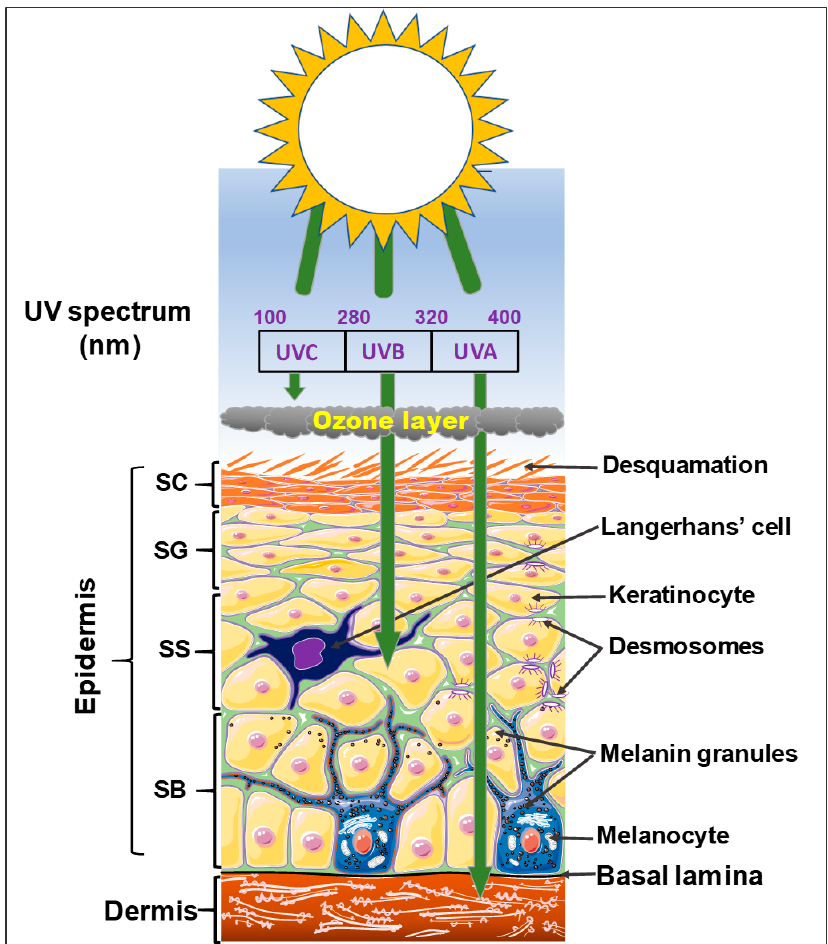
Figure 2. Schematic representation of the structure of the epidermis and papillary dermis. This stratified epithelium consists of basal, spinous, granular, lucidum, and stratum corneum layers. The basal layer contains the stem cells that sit or attach to the basal lamina via hemidesmosomes. In normal epidermis, basal keratinocytes express K5, K14, and integrins. The suprabasal and differentiating layers of keratinocytes are committed to differentiation, expressing K1, K10, and other markers, like filaggrin and loricrin. Other resident epidermal cell types include Melanocytes, Langerhans cells, and Merkel cells. The ultraviolet rays (UVR) from the sun penetrate the atmosphere and the different layers of the skin. UVC with the greatest energy photons (shorter wavelengths) is totally absorbed by the ozone layer while UVB with intermediate energy photons (wavelengths) that damage DNA in epidermal cells penetrates the upper layers of the epidermis. UVA with low energy photons (longer wavelengths) penetrates deeper into the upper dermis causing damage to collagen and elastic tissue, even skin cancers and other skin manifestations.